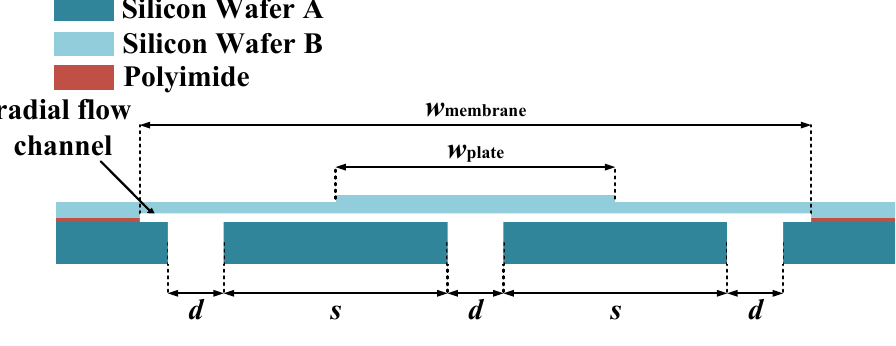
Figure 1. Schematic of the micro valve.